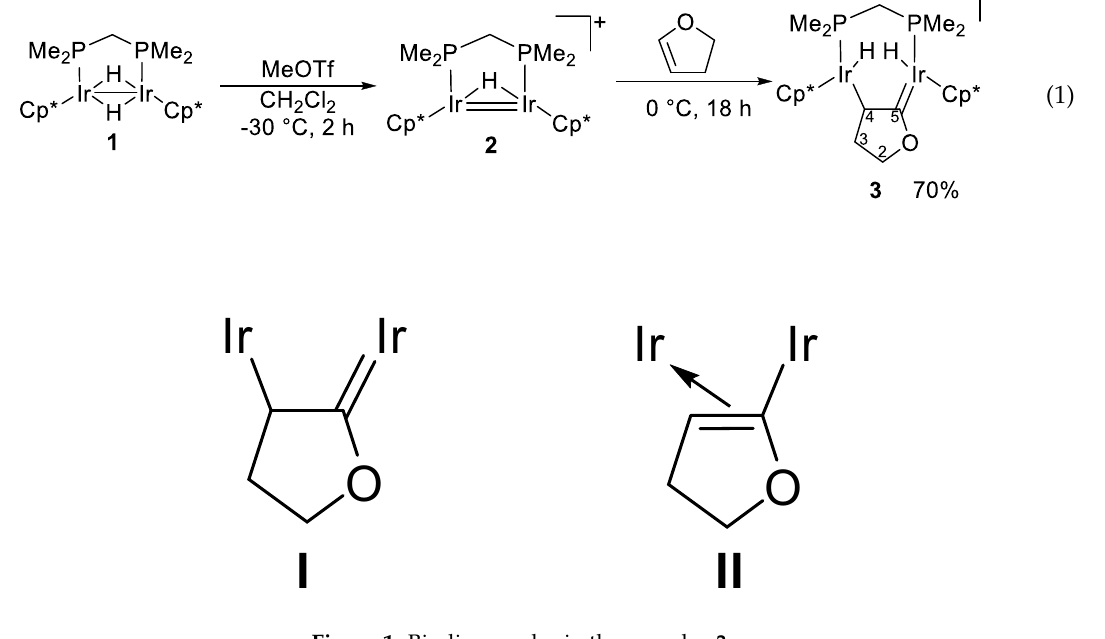
Figure 1. Binding modes in the complex 3 .